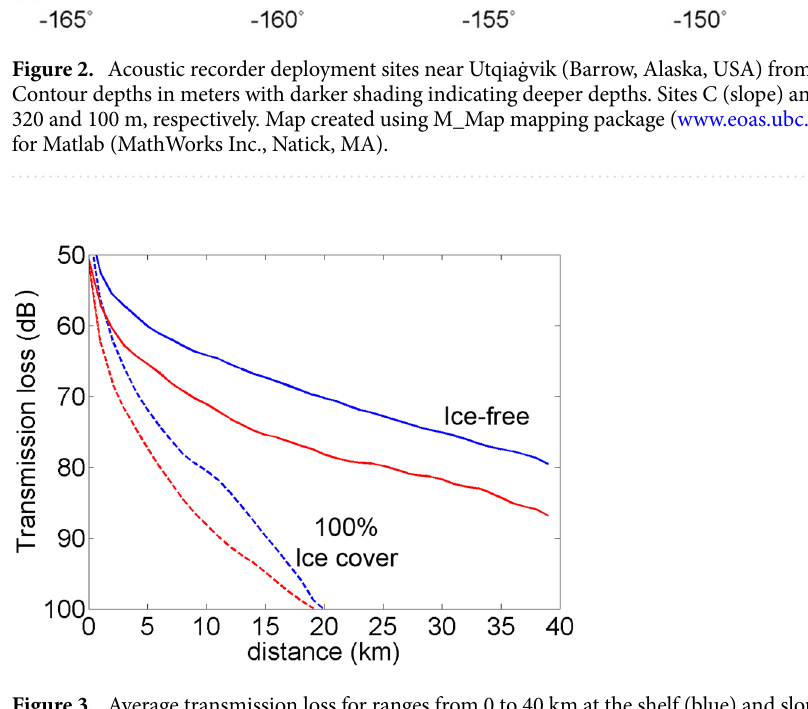
Figure 3. Average transmission loss for ranges from 0 to 40 km at the shelf (blue) and slope (red) sites in open water (solid lines) and ice-covered (dashed lines)